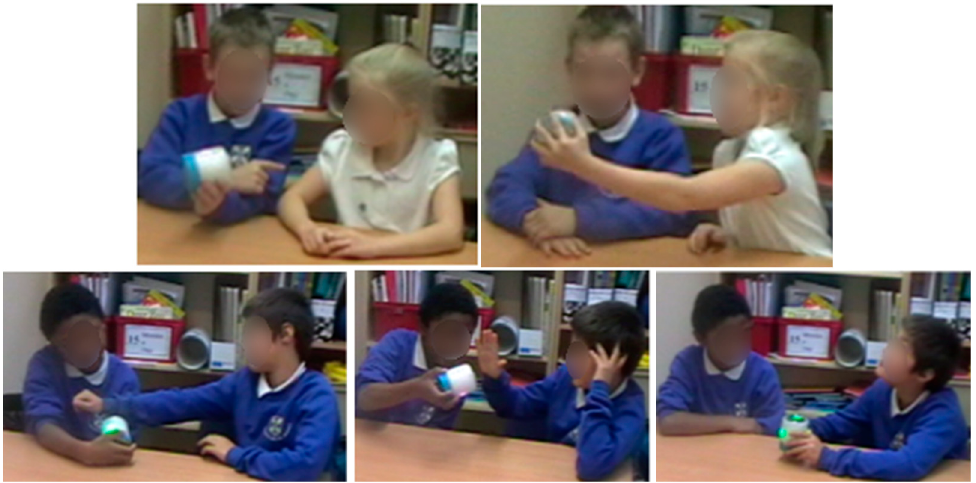
Figure 6. Students point object to different things to check if it changes colour accordingly.